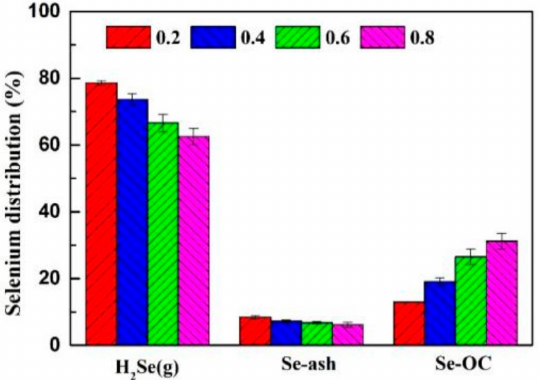
Figure 6. Selenium distribution at different O/C ratio during